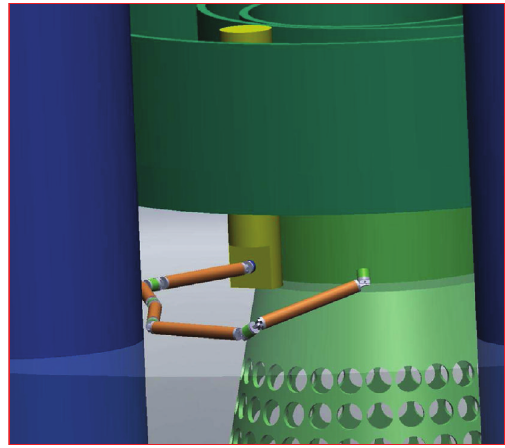
Figure 28: Insodium robotics for inspection/repair (CAD simula- tion example): articulated arm with NDE inspection